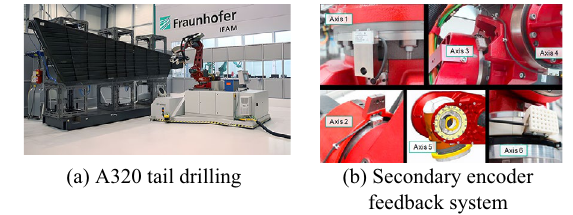
Figure 12 Mobile machining robot developed by Fraunhofer IFAM [42]